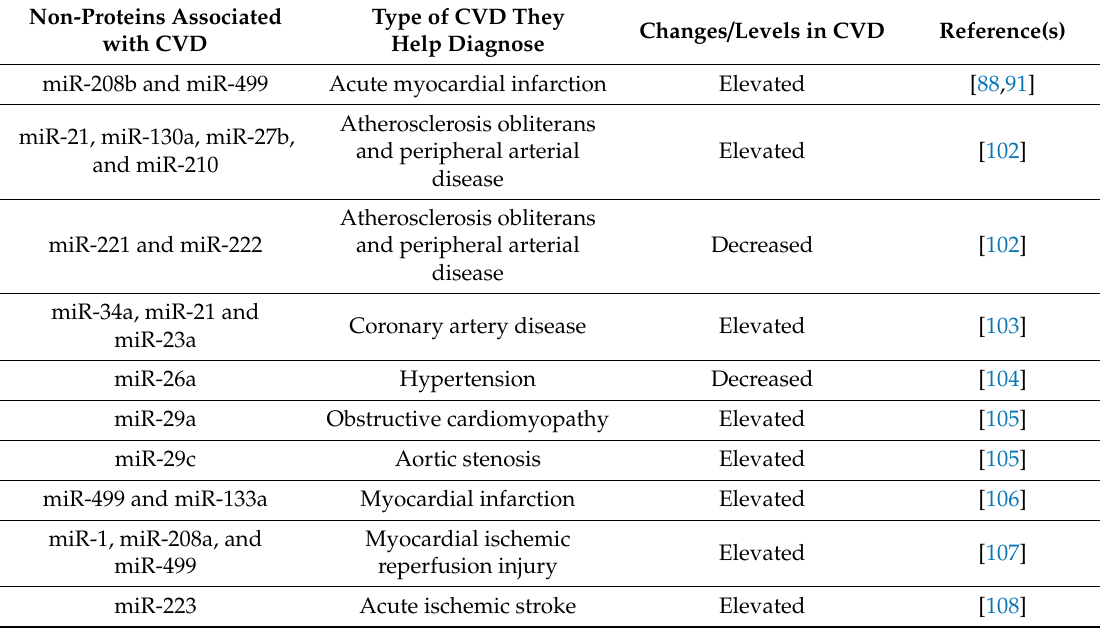
Table 3. Non-protein biomarkers of cardiovascular